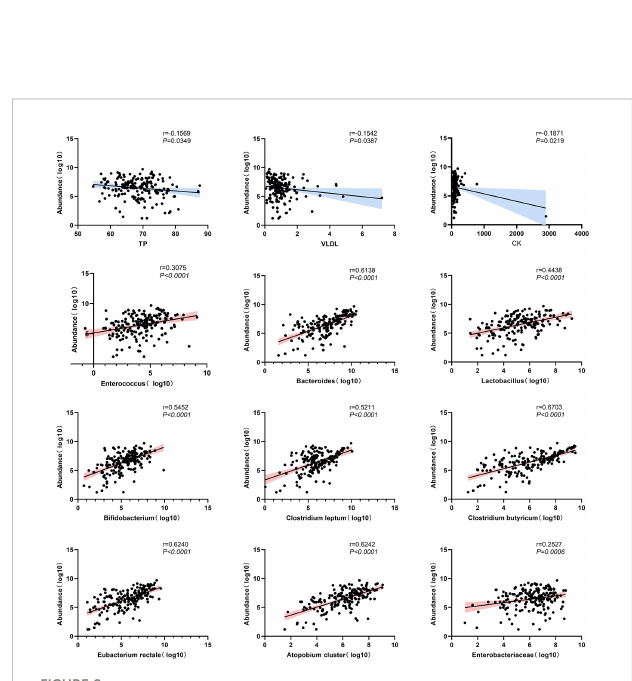
FIGURE 8 Scatterplot of univariate correlation analysis between F. prausnitzii and factors ( p -value <